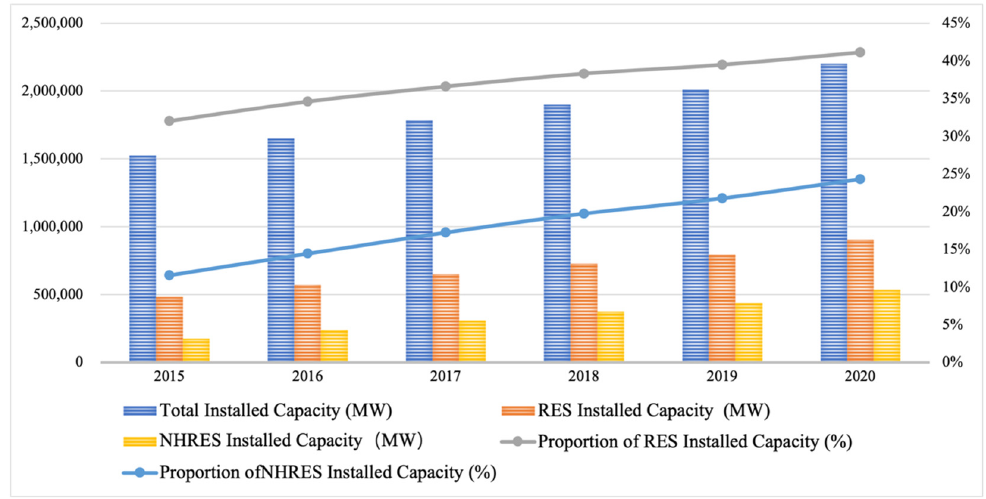
Figure 1. Total installed capacity and renewable energy capacity in China, and their respective shares.